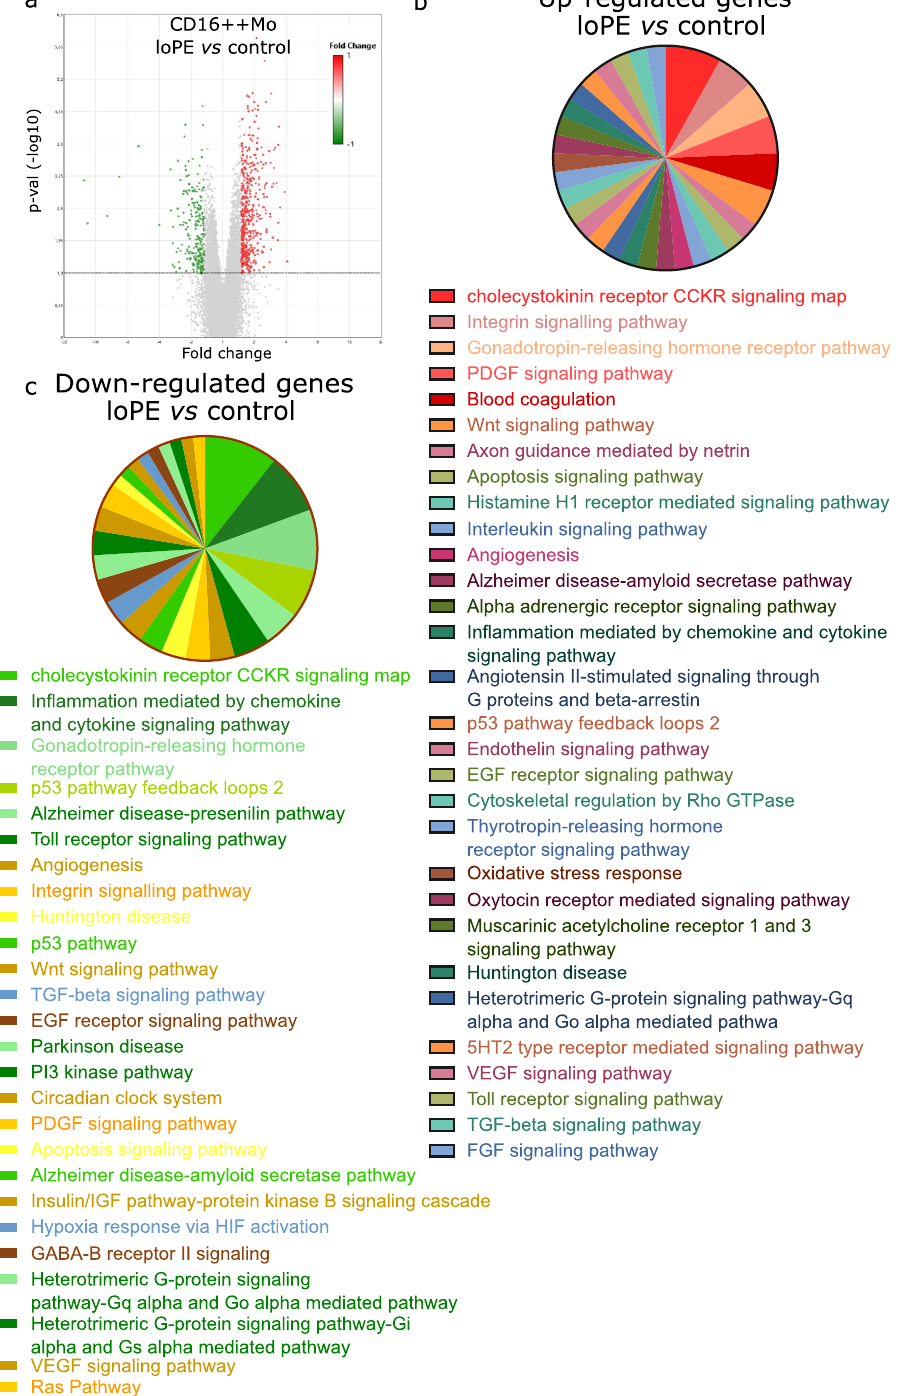
Figure 4. Transcriptomic data (relative gene expression levels) for CD16++ blood monocytes of late-onset PE (loPE) and control groups. Volcano plot ( a ) provides a comparative overview of gene expression of CD16++ monocytes of loPE (n = 6) vs control group (n = 6). Each point in the plot corresponds to a gene. The red- and green-colored genes positioned above the horizontal dotted line are significantly (p < 0.05) up- or down- regulated in loPE CD14++ cells, respectively. The data were analyzed with TAC Software 4.0.2 using Affymetrix default analysis settings and RMA algorithm. Enrichment analysis for upregulated genes ( b ) and downregulated genes ( c ) grouped in the PANTHER ontology by molecular pathway and listed in order starting from the most